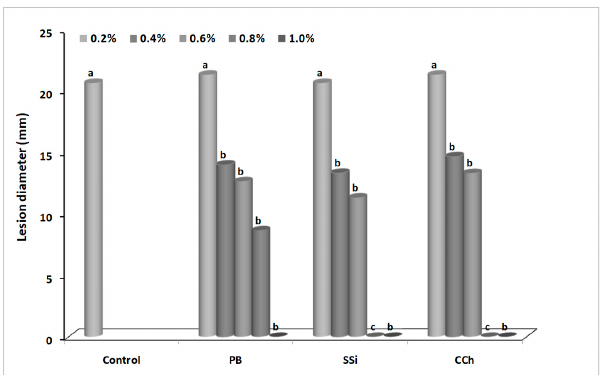
Figure 1. Decay incidence (% infected wounds) caused by Botrytis cinerea on ‘Italia’ table grapes untreated or treated with different concentration of potassium bicarbonate (PB), sodium silicate (SSi), and calcium chelate (CCh) after 4 days of incubation at 23 ± 1 °C. Values marked with the same letters are not statistically different by Fisher’s protected least significant difference test at p ≤ 0.05.